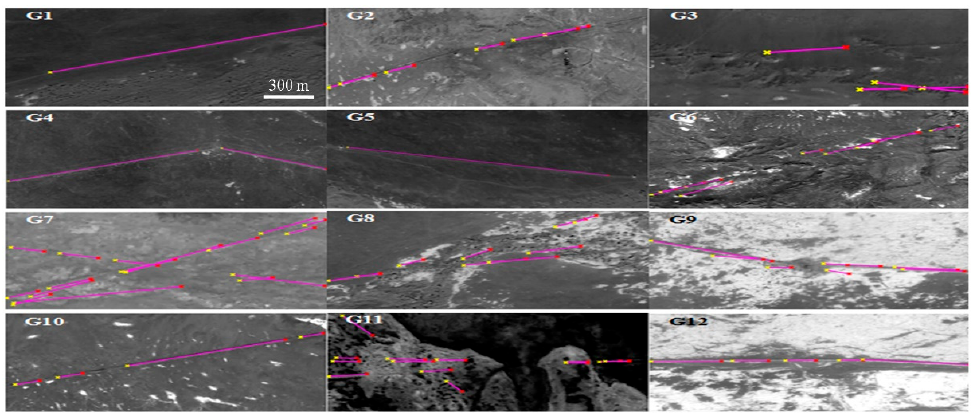
Figure 10. Results of automatic identification of 12 typical linear traces. Magenta lines represent the identified fragments of linear traces, and yellow and red points represent the start and end points of the extracted lines, respectively.